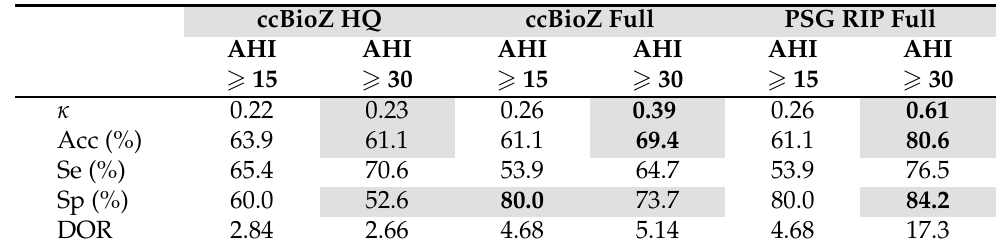
Table 4. Performance of the OSA patient detection model on the high-quality ccBioZ, full ccBioZ and full PSG RIP recordings of the Test dataset. The main results are indicated in grey, of which the best results are in bold.